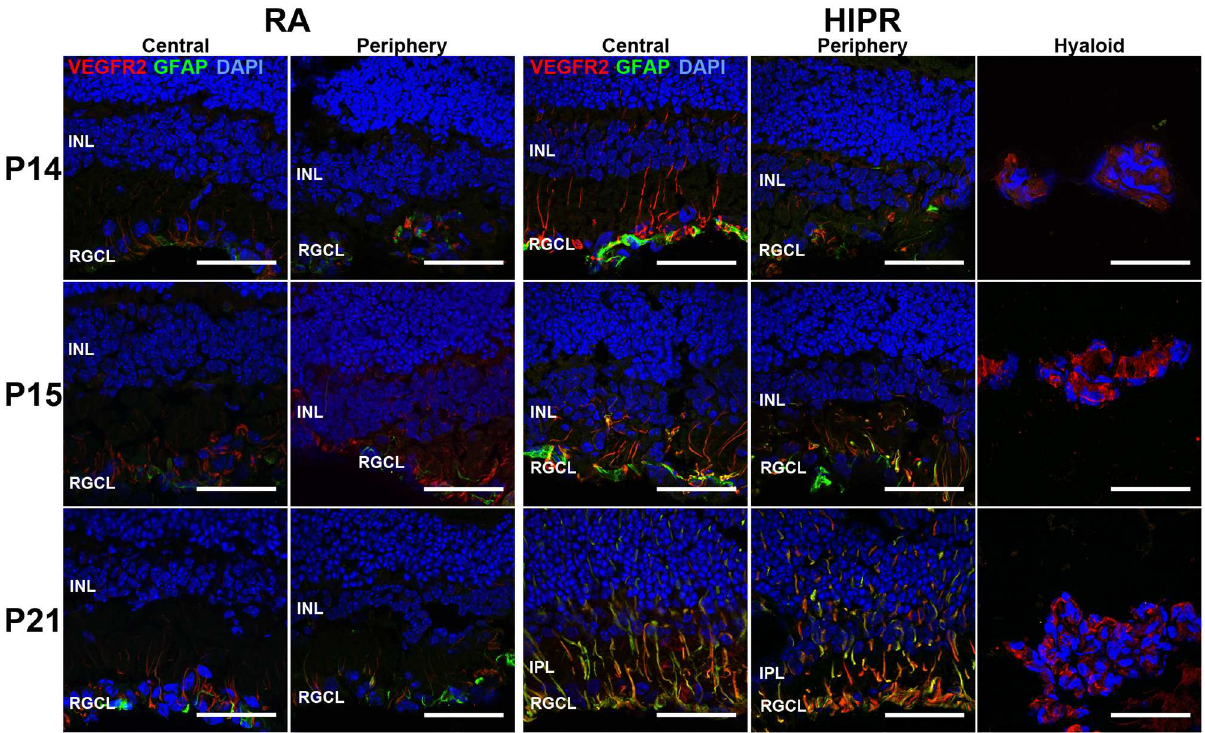
Fig 4. Retinal VEGFR2 levels increased in hyperoxia-induced proliferative retinopathy. Immunohistochemistry revealed VEGFR2 (red) cellularlocations.Sections were stained with GFAP (green) for activated Mller cells (N = 3). In HIPR, VEGFR2 was co-localized with GFAP by P21. High intensity VEGFR2 stainingwas seen in the persistent hyaloidal vessels in HIPR. INL, inner nuclear layer. RGCL, retinal ganglioncell layer. IPL, inner plexiform layer. Scale bar, 50 μ m.